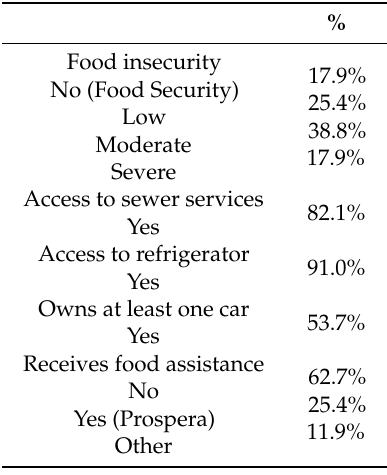
Table 3. Household-level properties ( n = 67 households).